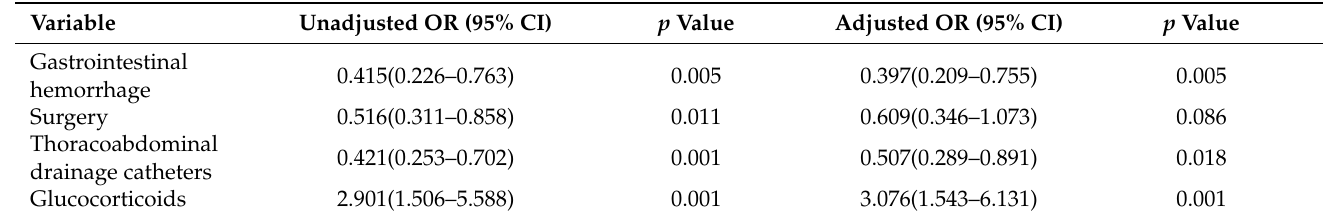
Table 5. Multivariate analysis of possible risk factors regarding C. albicans vs. NAC candidemia.